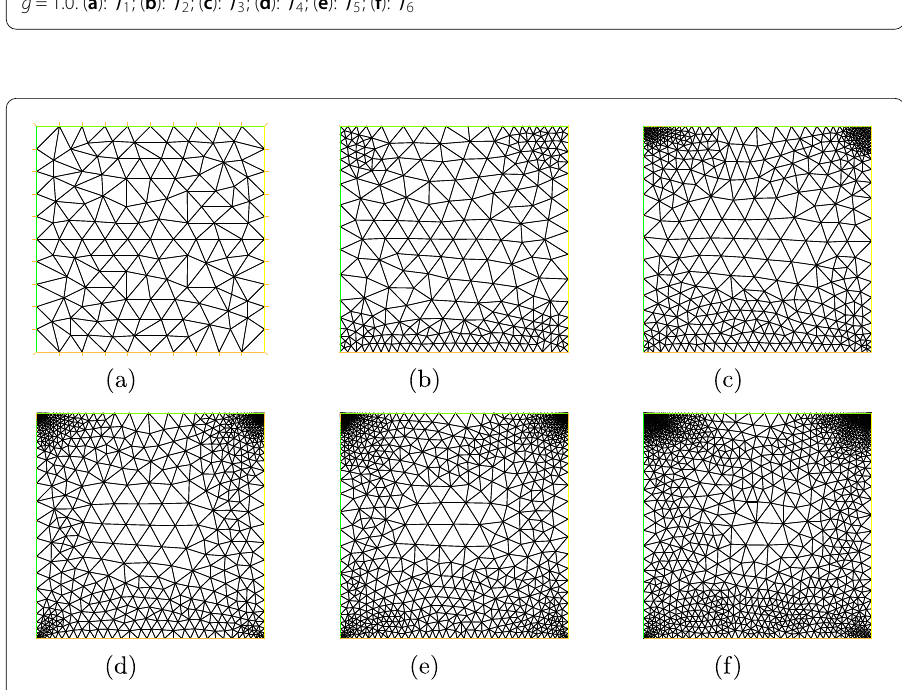
Figure 6 Adaptive refinements by P 1 – P 0 stabilized method for the cavity flow with slip boundary condition: g = 10.0. ( a ): T 1 ; ( b ): T 2 ; ( c ): T 3 ; ( d ): T 4 ; ( e ): T 5 ; ( f ): T 6